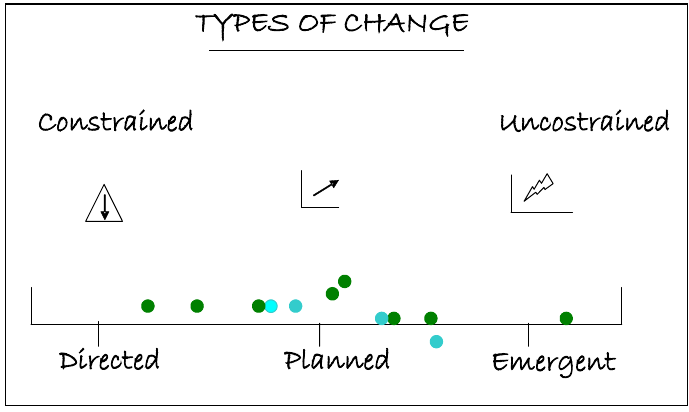
Figure 6: Conceptualizing Change Strategies at IM